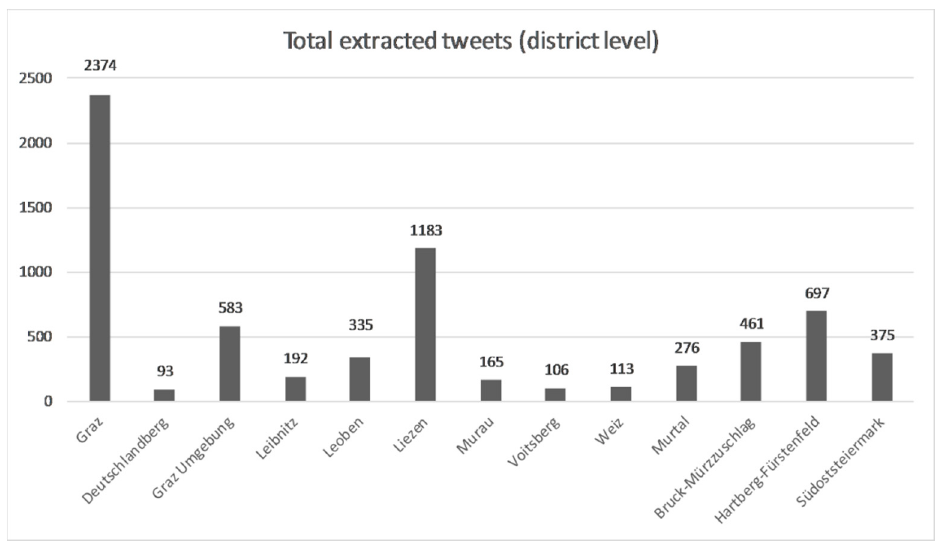
Figure 4. Number of extracted tweets for each district of the Province of Styria. On the y-axis the number of total tweets and on the x-axis the districts are depicted.